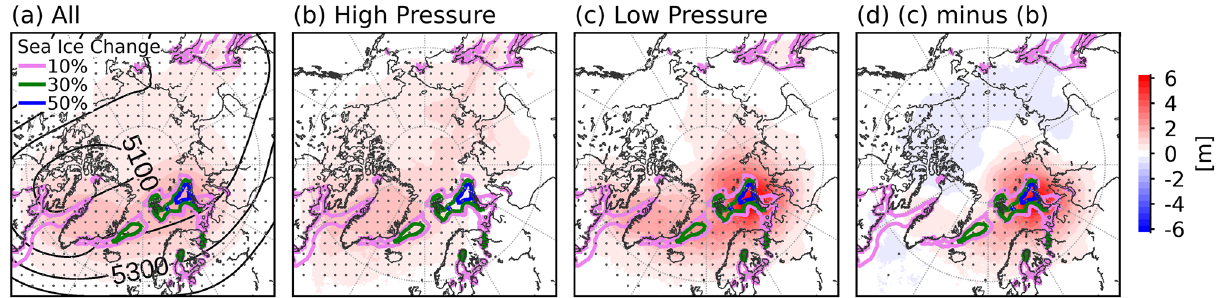
Figure 1. ( a – c ) Responses of wintertime (Dec–Feb) 500 hPa geopotential height to sea ice loss for ( a ) all “control” run period (2006/07–2015/16), ( b ) “high-pressure” cases, and ( c ) “low-pressure” cases. The response is obtained by subtracting the “high sea ice concentration (High SIC)” run from the “control” run of Polar WRF. The “control” run is an ensemble of 48-h simulations initialized daily during the period and the “High SIC” run is identical to the “control” run but with adding the wintertime sea ice concentration difference between two periods (1979/80–1988/89 minus 2006/07–2015/16). “High-pressure” and “Low-pressure” cases are days with the top and bottom 5% of the 500 hPa geopotential height over the Barents Sea region (70–80°N, 15–75°E). ( d ) Difference between the mean response of the “high-pressure” cases and the mean response of the “low-pressure” cases. The values are daily averages at day 2 of model integration (24-to-48-h). Differences that are statistically significant based on a Student’s t test at the 99% confidence level are stippled. Colored contours indicate the SIC differences between the “control” and “High SIC” runs. Black contours in ( a ) are the mean 500 hPa geopotential field for the control run. The map has been created using Matplotlib Basemap Toolkit ver. 1.3.0 (https:// matpl otlib. org/ basem ap/).